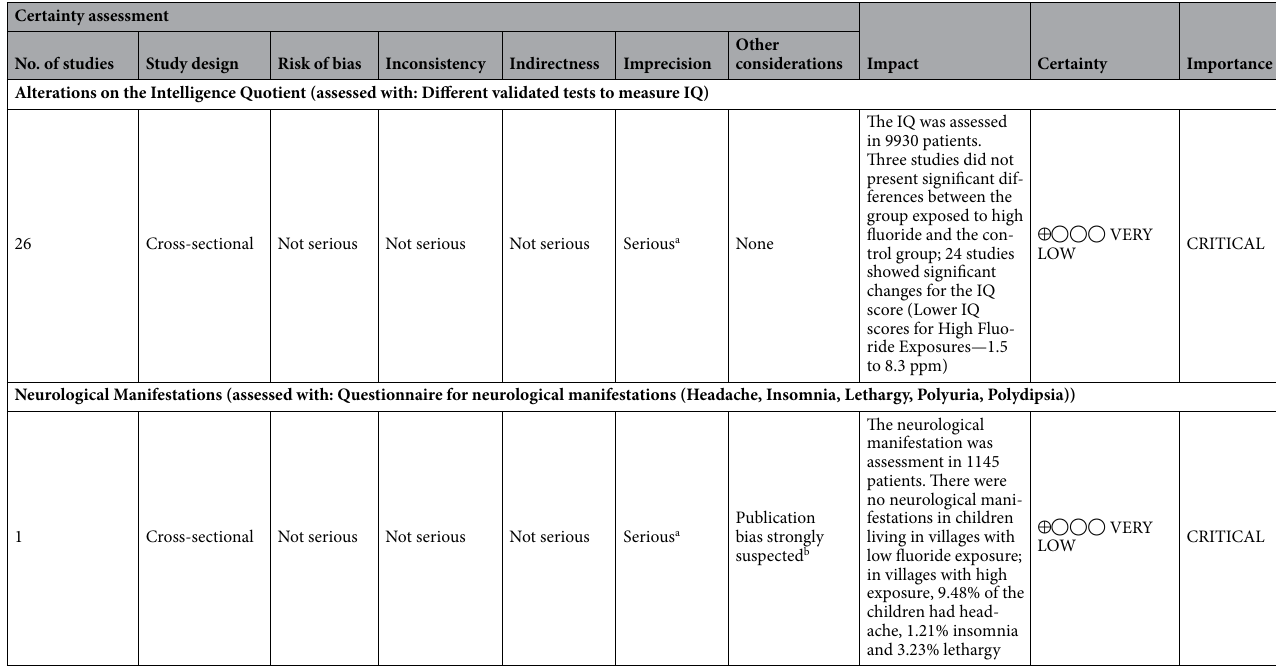
Table 3. GRADE evidence profile table. a Narrative synthesis was conducted, non-precise estimates and effects not estimated. Eswar et al., 2011; Kundu et al. 2015; Qin et al., 2008; Sharma et al., 2009; Trivedi et al., 2012; Wang et al., 2008; Wang et al., 2006 and Zhao et al., 1996; b Non-validated questionnaire, and has no specificity.